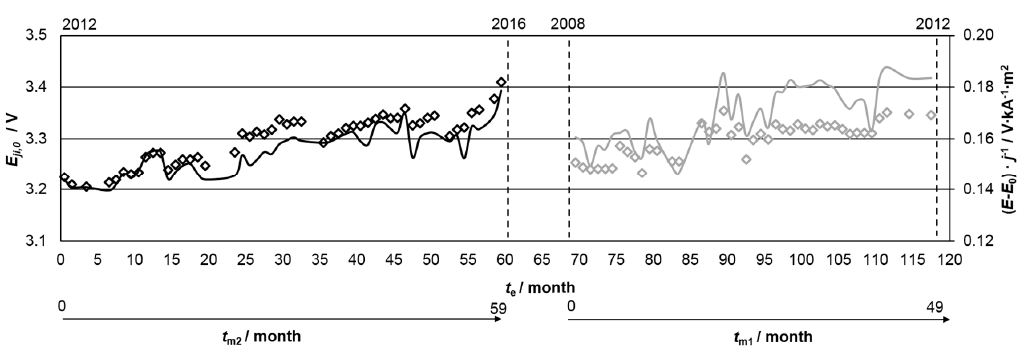
Figure 4. Normalized potential ( ♦ ), E ji ,0 , and the correspondent ohmic resistance (-), (E − E 0 ) · j − 1 , as a function of the electrode and membrane service times, respectively t e and t mi .